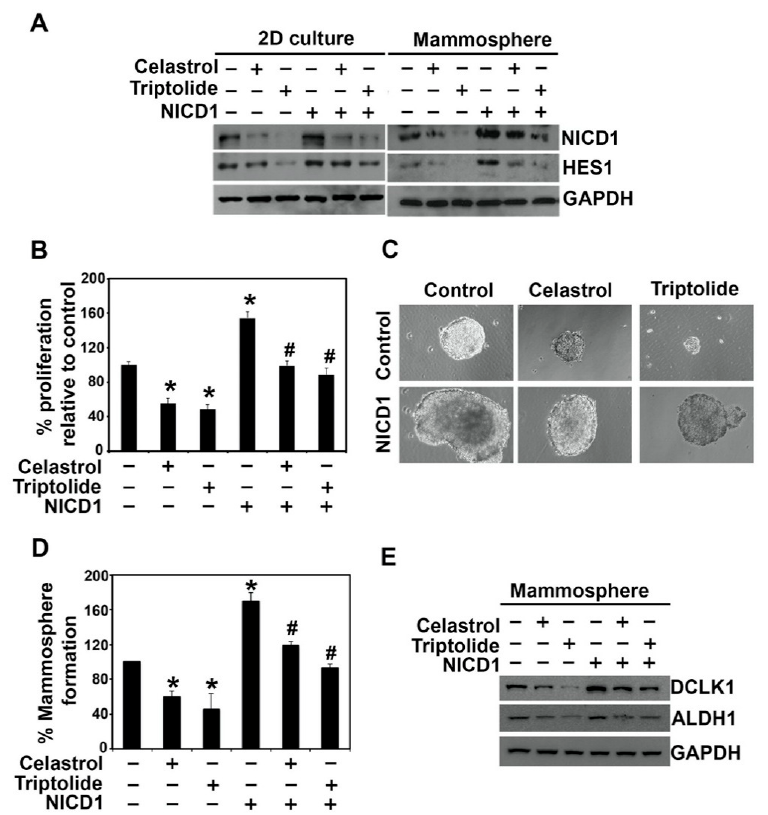
Figure 6. Overexpression of NICD1 partially protects from celastrol and triptolide treatment in BT20 cells. ( A ) NICD1 overexpression rescues cells from celastrol and triptolide-mediated suppression of NICD1 and HES1 expression. The cells were treated with the compounds for 48 h in cells overexpressing NICD1, and cell lysates were analyzed by western blotting. Increased protein expression of NICD1 and HES-1 was observed in the NICD-expressing cells when compared with vector controls. Celastrol and triptolide reduced the expression of NICD1 and HESI., but this was partially restored in NICD1 overexpressing cells. ( B ) NICD1-overexpressing BT20 cells overcome the suppression of cell growth in celastrol and triptolide. Each value represents mean ± SD of four separate estimations, n = 3. * p < 0.05 when compared with vector control; # p < 0.05 when compared with NICD1 overexpression control. ( C , D ) Mammosphere cultures show partial protection from celastrol and triptolide-induced spheroid growth in NICD1 overexpressing cells. Each value represents mean ± SD of four separate estimations, n = 3. * p < 0.05 when compared with vector control; # p < 0.05 when compared with NICD1 overexpression control. ( E ) DCLK1 and ALDH1 protein expression were decreased in celastrol and triptolide treatment but restored in NICD1 overexpressing cells after